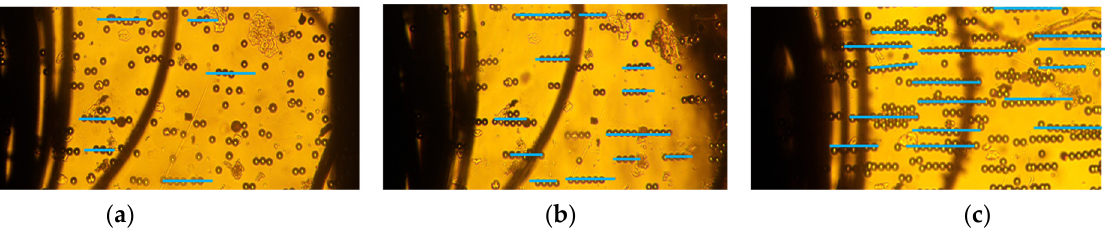
Figure 2. Pearl chain formation of PS microbeads due to positive DEP in low conductivity solution (0.001 mS/m) in thread-based electrodes at ( a ) 1 V, ( b ) 3 V, and ( c ) 6 V @2 kHz.